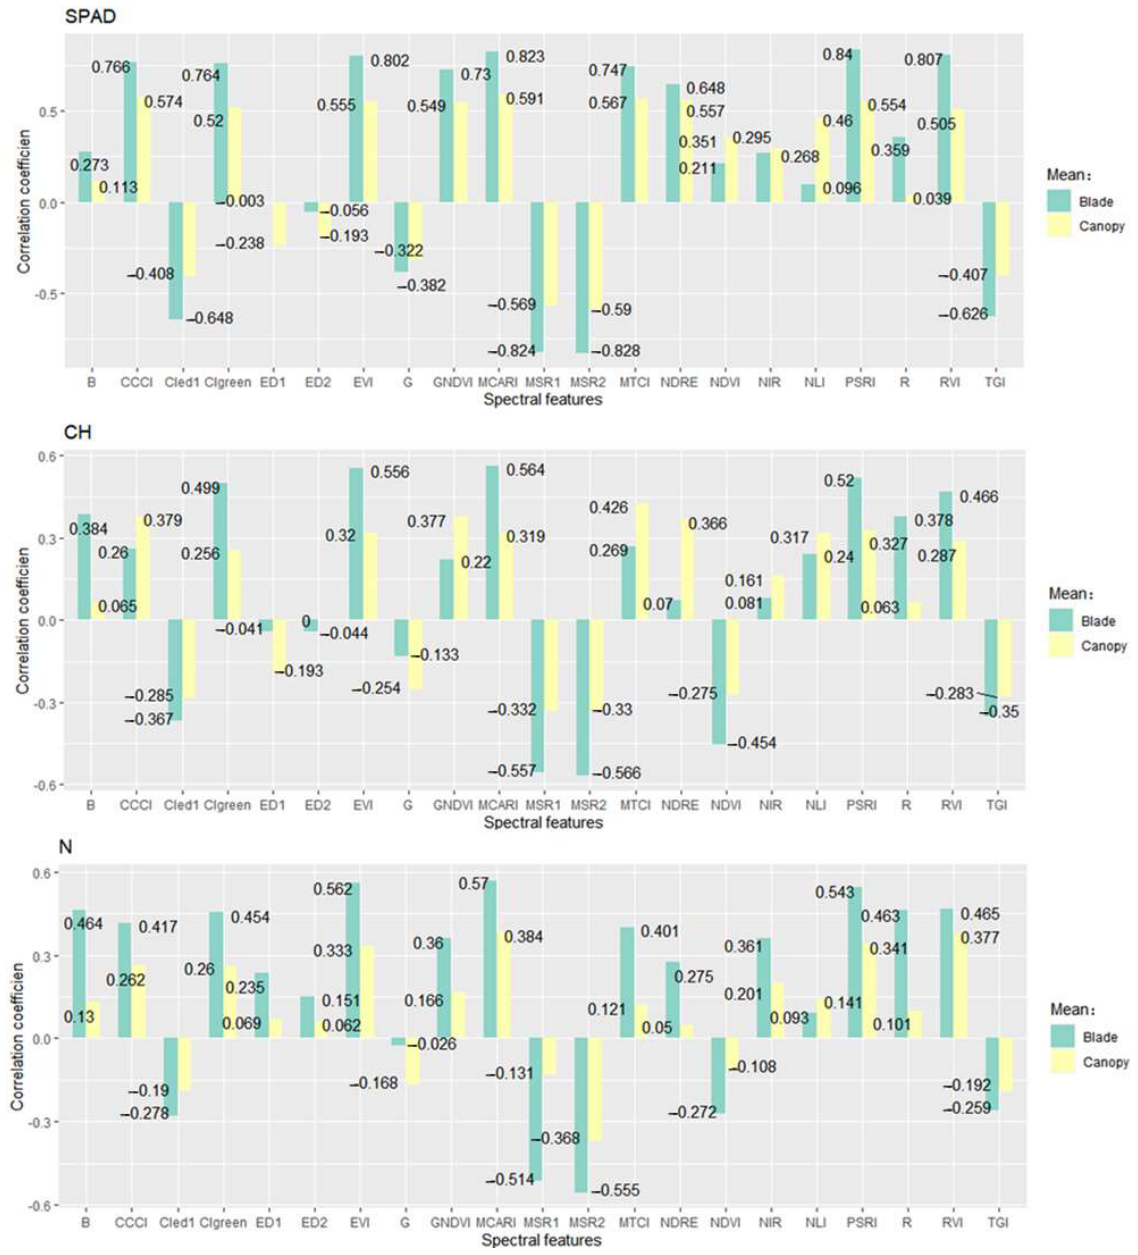
Figure 10. Correlation coefficients of leaf physiological parameters at the top with vertical ground- probe spectral features. Blade represents the vegetation index calculated from the leaf-scale multi- spectral images. Canopy represents the vegetation index calculated from the canopy-scale multi- hyperspectral images. SPAD, the value measured with the spad-502 plus instrument; CH, total chlorophyll content; and N, total nitrogen content.